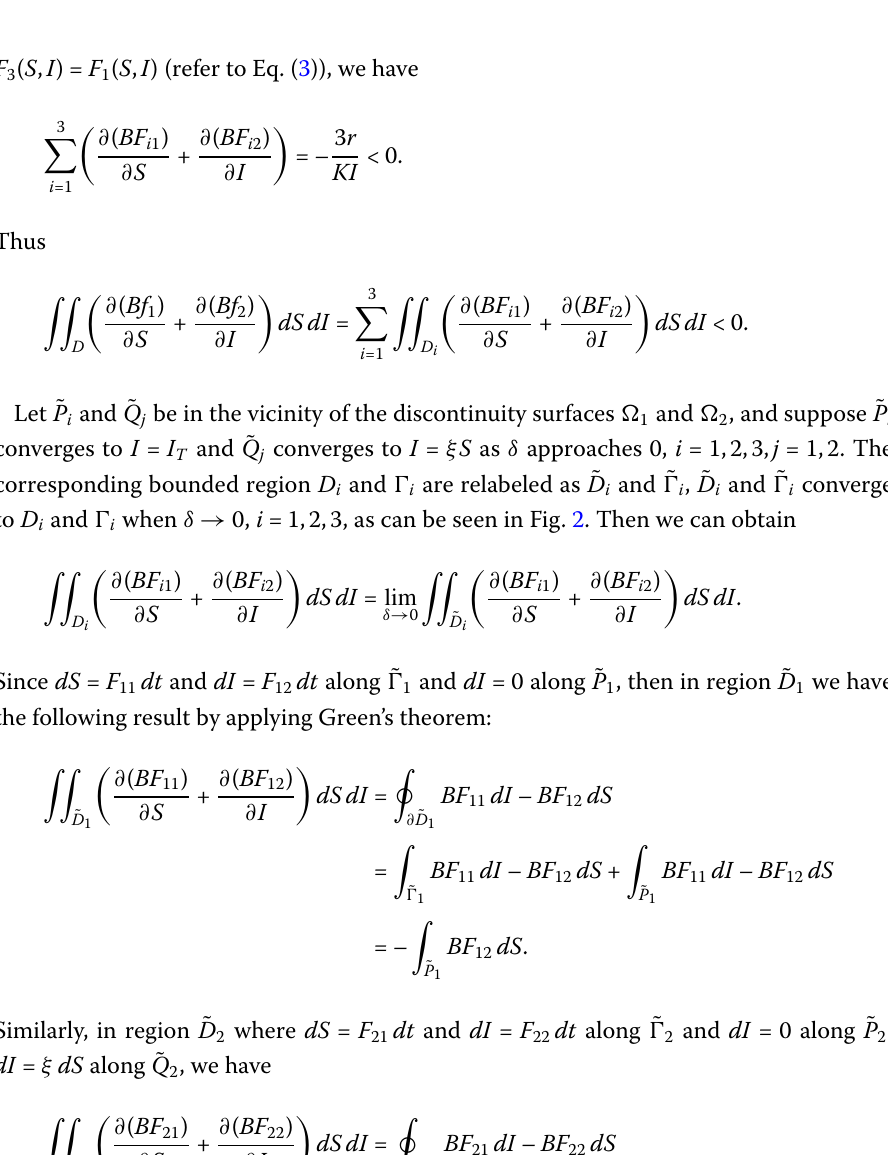
Figure 2 Case A.1: The nonexistence of a limit cycle in system (1)–(2) where E R 2 is a real equilibrium